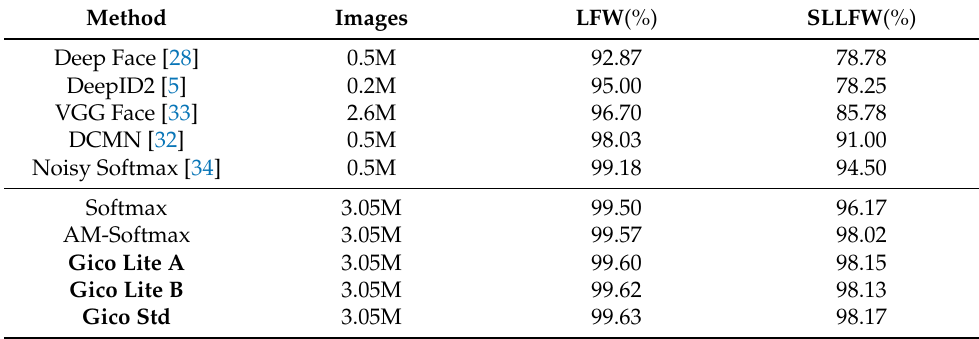
Table 5. Verification performance of different methods on